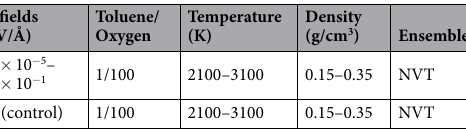
Table 1. Details of ReaxFF MD